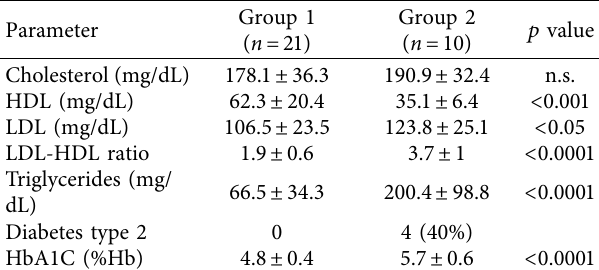
Figure 3: (a) Correlation of ActiTest with triglycerides, (b) correlation of ActiTest with CRP, (c) correlation of ActiTest with CAP, and (d) correlation of ActiTest with LSM. Table 4: Metabolic